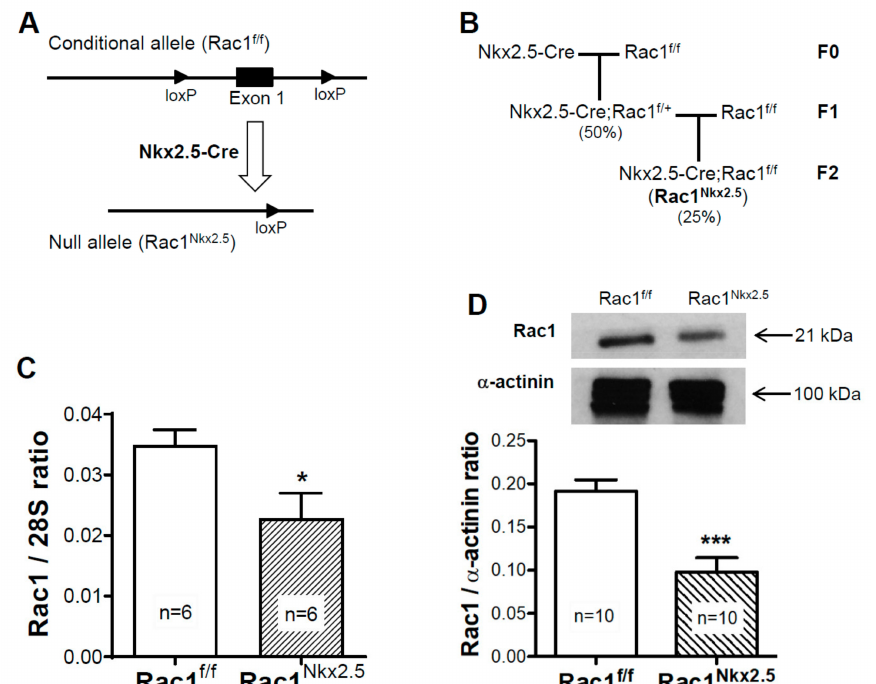
Figure 1. Generation of mouse line with a myocardium specific deletion of Rac1 ( Rac1 Nkx2.5 ). A schema of the floxed Rac1 allele and Nkx2.5-Cre mediated generation of the Rac1 null allele ( A ). Rac1 Nkx2.5 mice were generated by crossing Nkx2.5-Cre transgenic mice with Rac1 f/f mice for 2 generations with the expected genotype frequencies indicated in brackets ( B ). Rac1 mRNA expression was significantly reduced in E12.5 Rac1 Nkx2.5 ventricular myocardium compared to Rac1 f/f littermates ( C ). Western blot analysis of E12.5 ventricular myocardium showed a significant decrease in Rac1 protein levels in Rac1 Nkx2.5 hearts compared to controls ( D ). * p < 0.05, *** p < 0.001 by unpaired Student’s t -test.